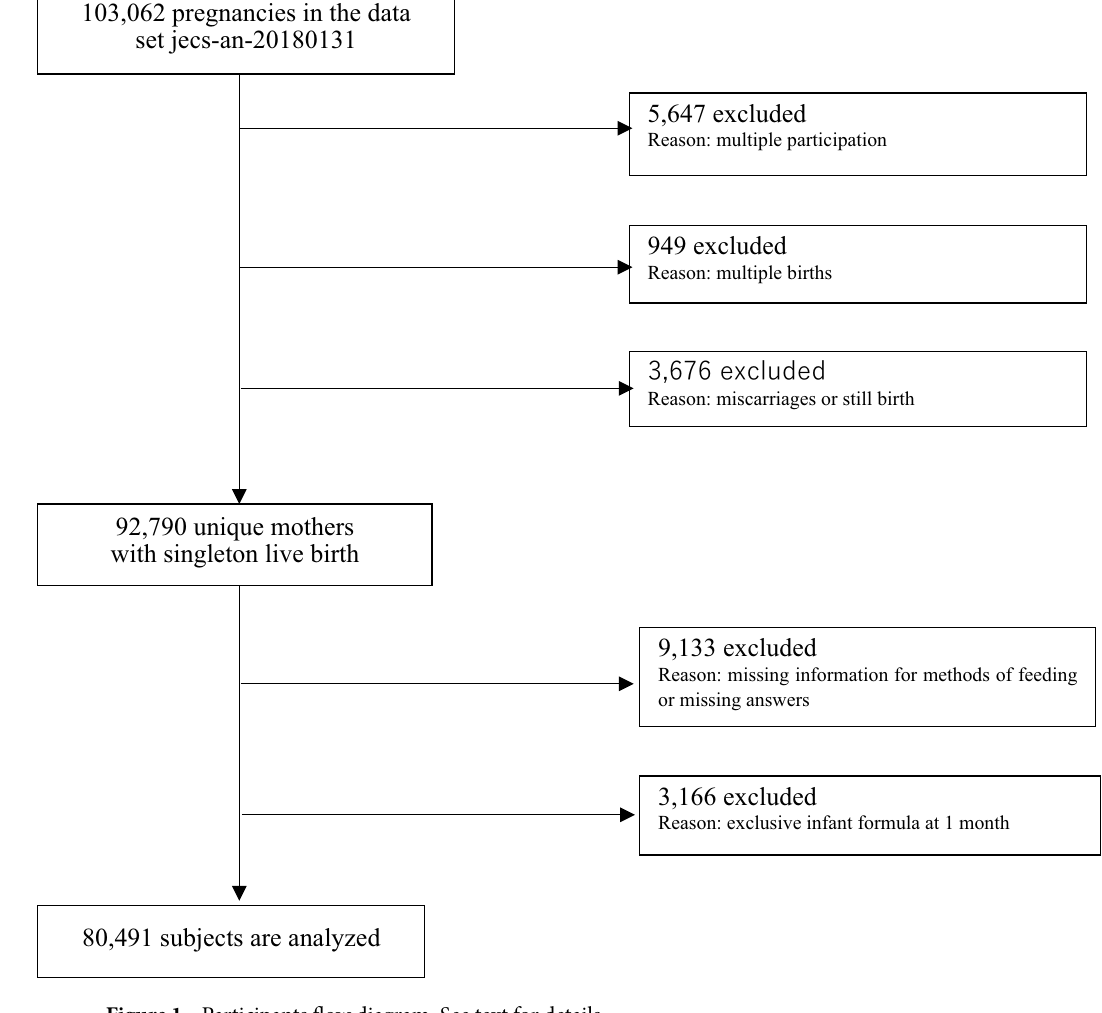
Figure 1. Participants flow diagram. See text for